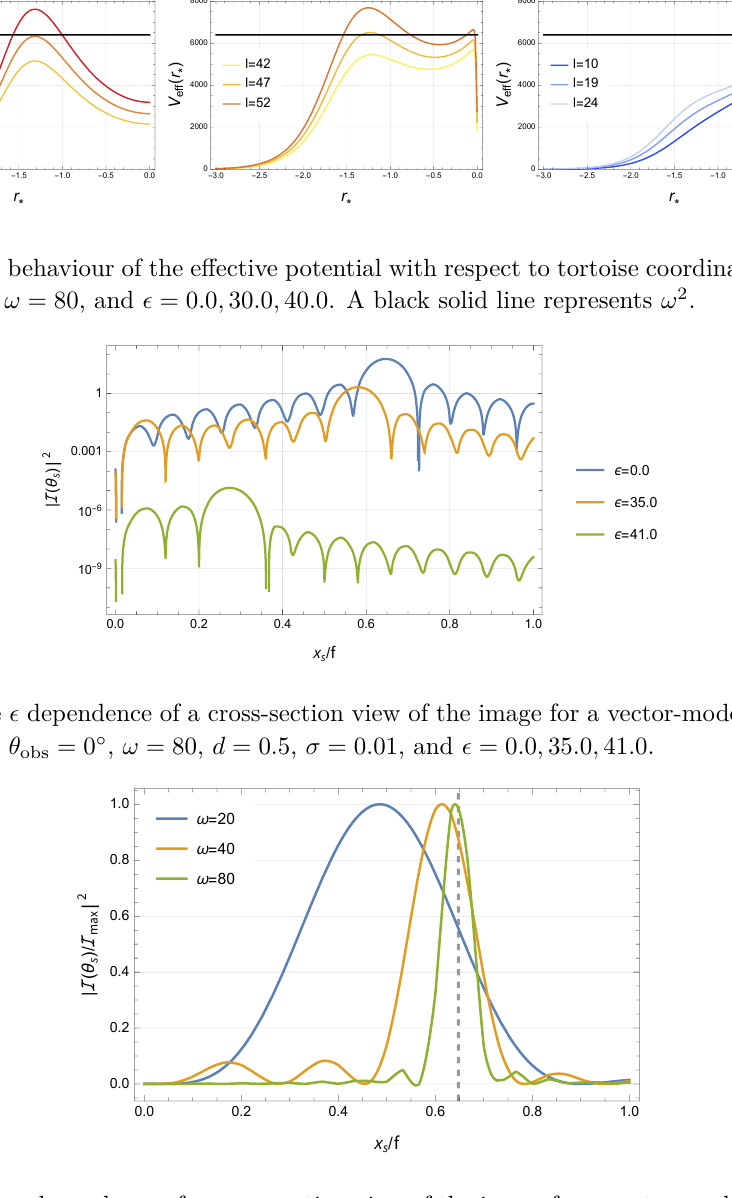
Figure 14 . The ω dependence of a cross-section view of the image for a vector-mode perturbation. A gray dashed line represents a photon sphere radius calculated from the geodesic approximation. σ = 0 . 01 . The vertical line is the image amplitude which is normalized by the maximum amplitude, and the horizontal line is x /f . A gray dashed line represents the photon sphere s radius calculated from the null geodesic approximation. The ring image becomes blurred as we decrease ω due to the wave effect. We can see x /f of the maximum amplitude gets s closer to the photon sphere radius calculated from a null ray approximation as we raise ω